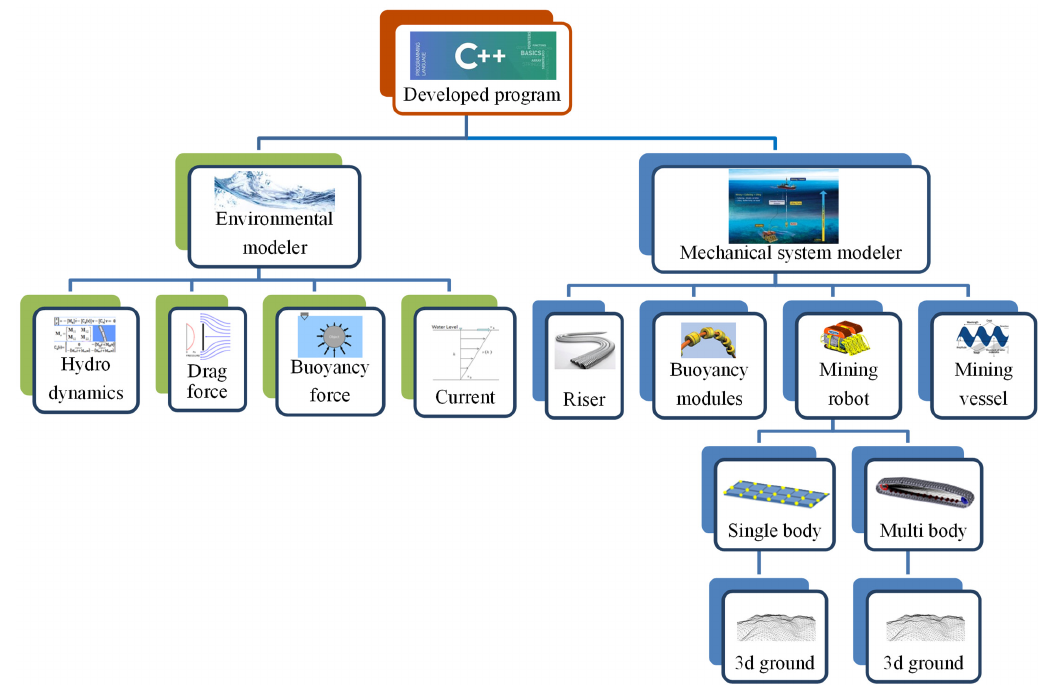
Figure 20. Structure and user interface of the developed program.